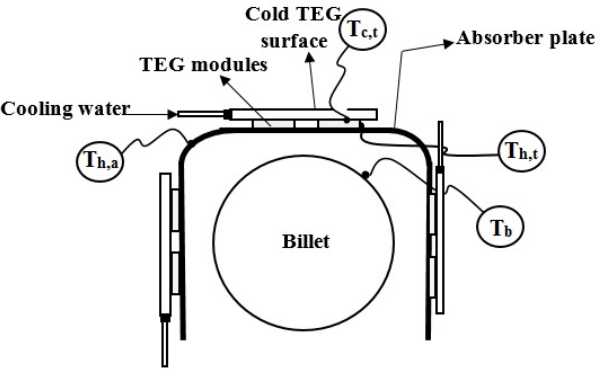
Figure 4. Experimental measuring locations of temperature in the TEG system.